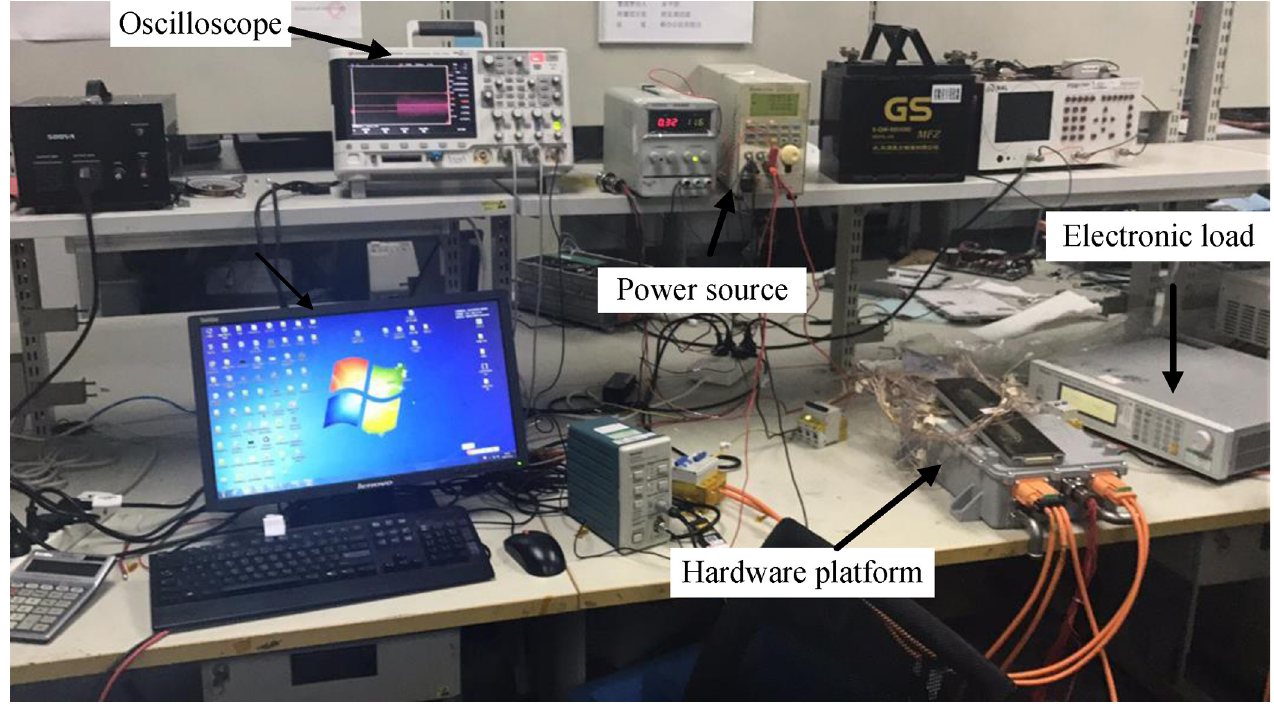
Fig 25. The experimental prototype of a dual-output port on-board charging system.